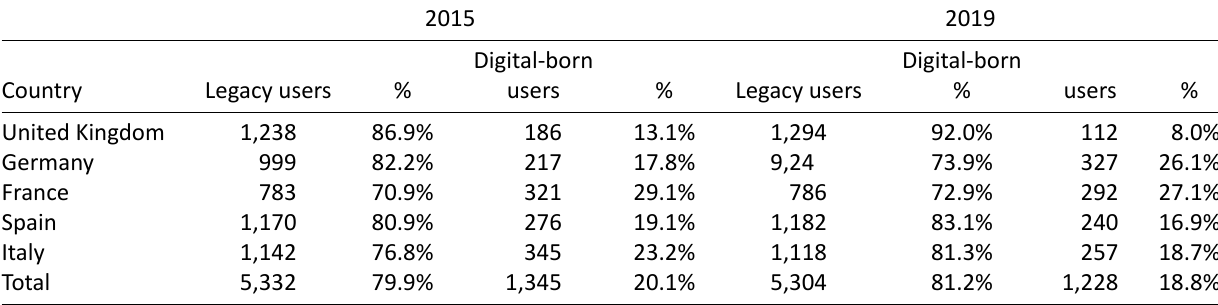
Table 2. Subsample: Legacy and digital-born users (2015 and